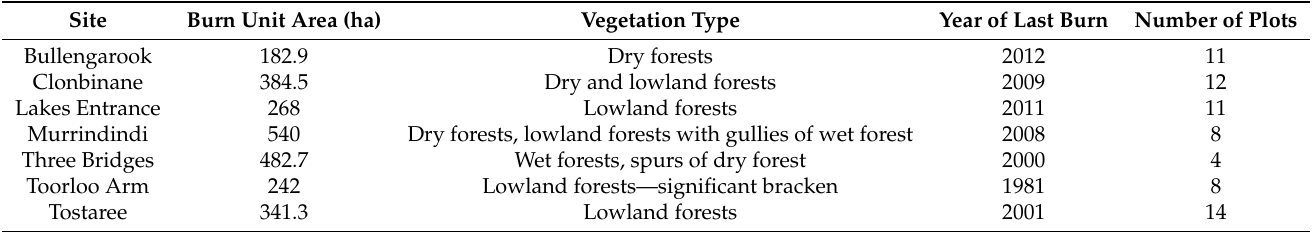
Table 1. The properties of the seven study sites used in this study. Date of last burn was provided by the Victorian Department of Environment, Land, Water, and Planning. The type and severity of the burn were not